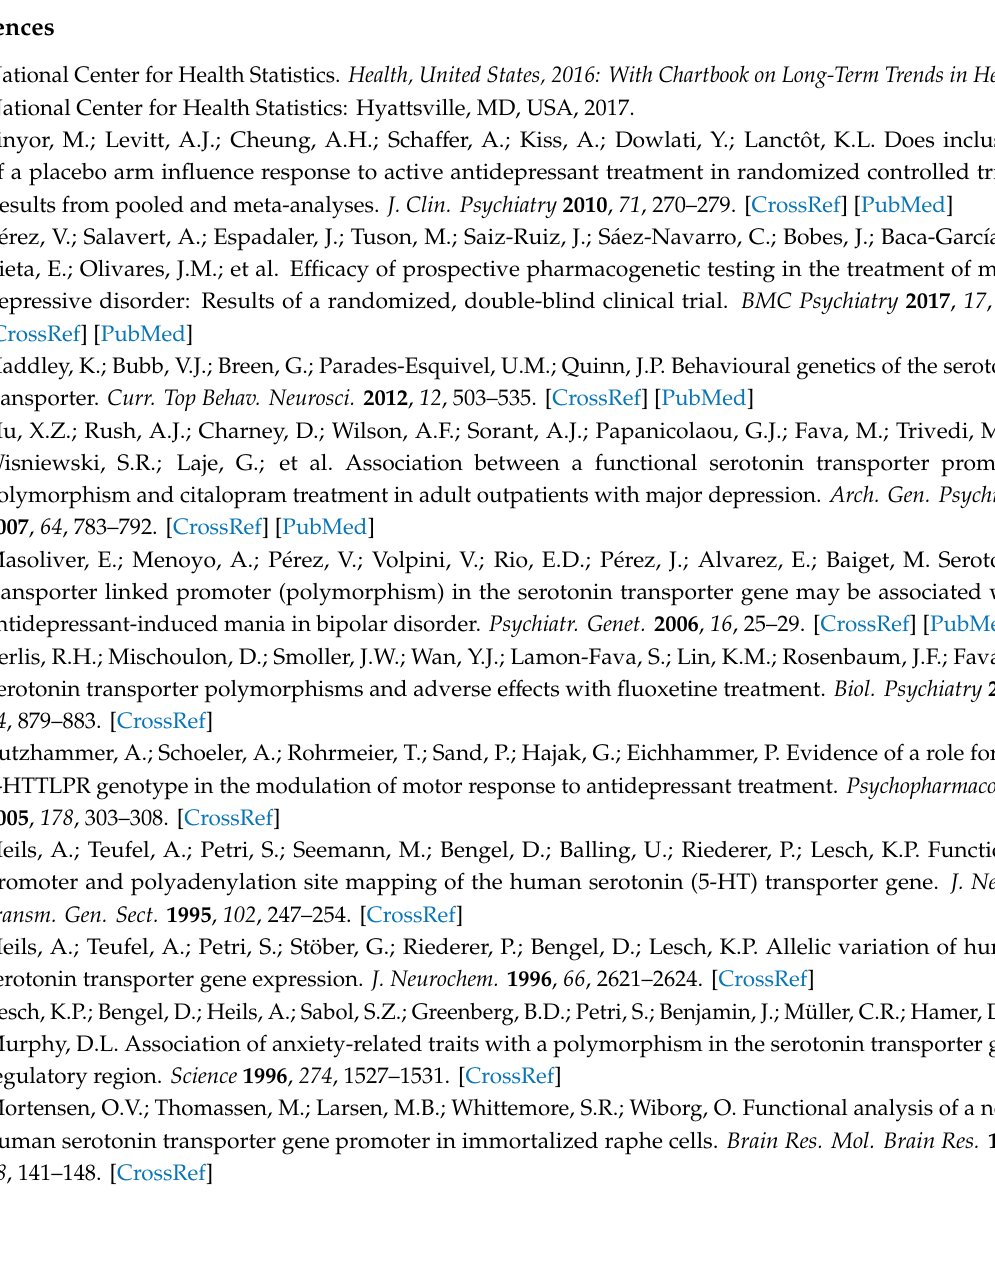
Table S1: Summary of SLC6A4 Samples and Datasets. Table S2: Summary of SLC6A4 Promoter Sequencing Results. Table S3: Summary of Additional SLC6A4 Promoter Variants Detected by Long-Read SMRT Sequencing. Table S4: SLC6A4 Promoter Sanger Sequencing Confirmation. Table S5: Summary of SLC6A4 Long-Read SMRT Sequencing Precision. Figure S1: Representative Sanger sequencing results from selected SLC6A4promoter reference material